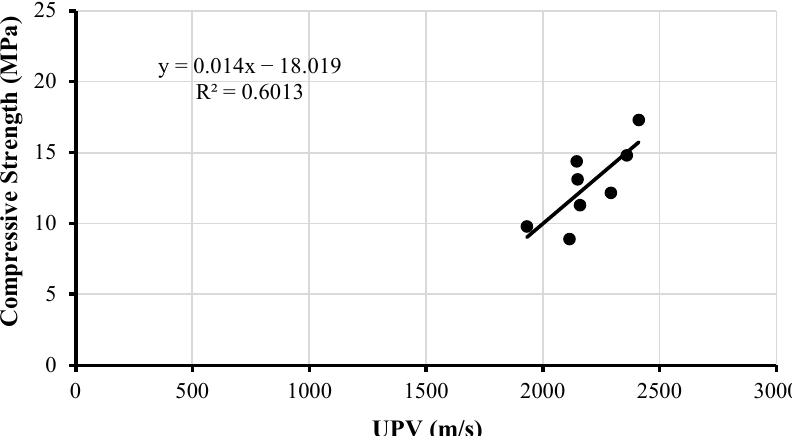
Figure 11. Compressive strength vs. UPV of 75-year-old bricks.